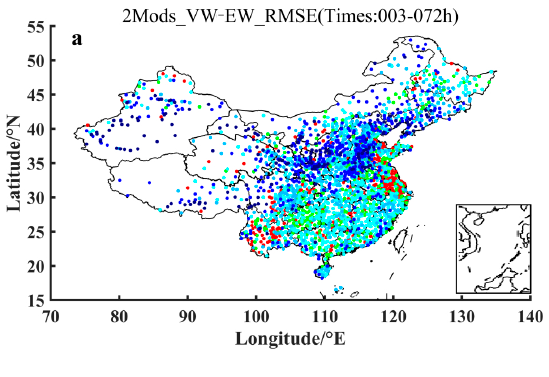
Figure 4. Averaged variations of 2 m temperature prediction RMSEs (units: °C) over 2380 surface stations of China for October 2015 with respect to the various prediction leading times for the 2-, 3- and 4-models ensemble forecasting using VW and EW ensemble methods as compared with that of the ECWMF forecasting.